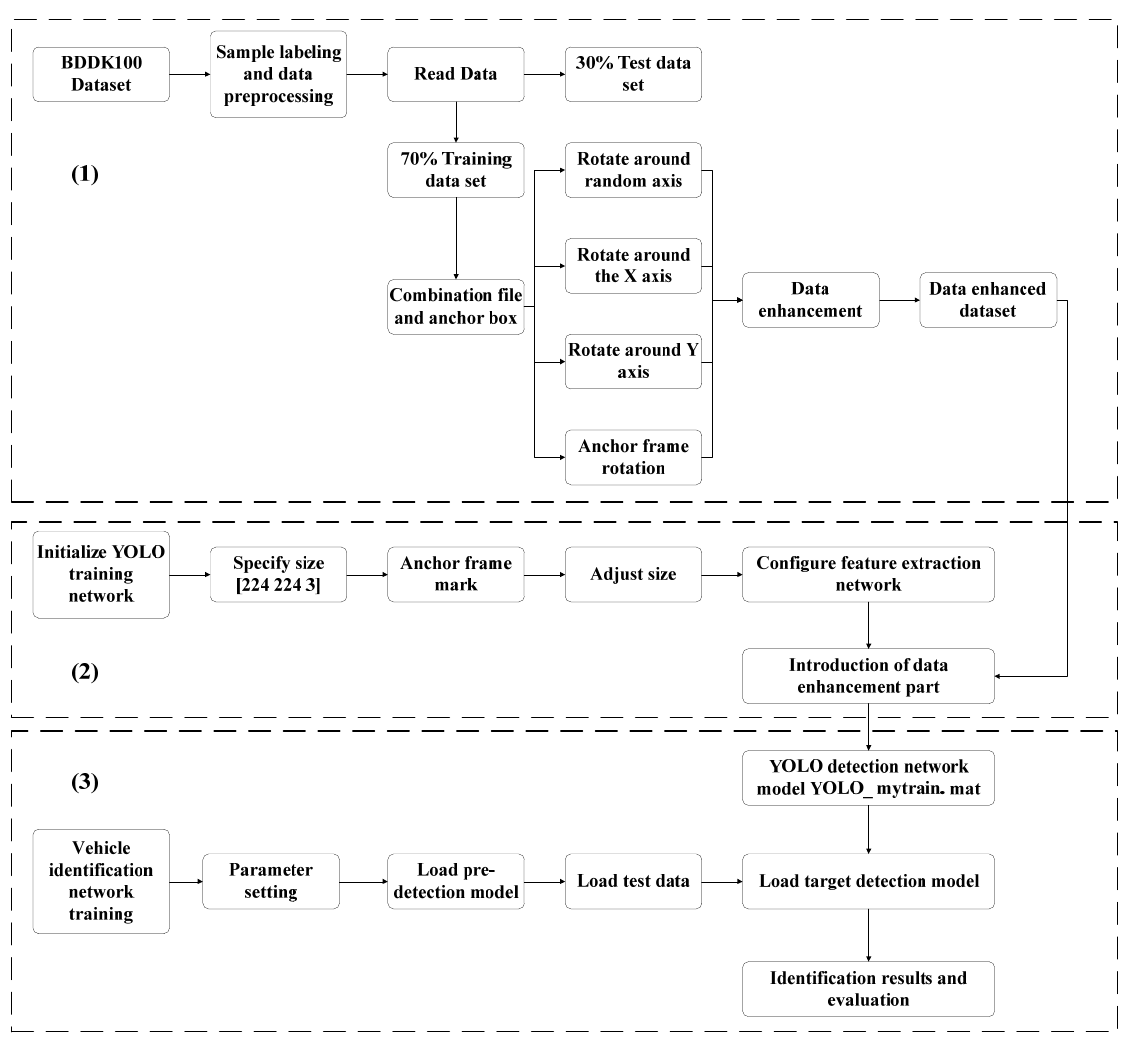
Figure 11. The method flow chart of this paper. The data processing flow includes three parts: (1) data set preprocessing and data enhancement, (2) initialization of the YOLO training network, and (3) vehicle identification network training and testing. vehicle identification network training and